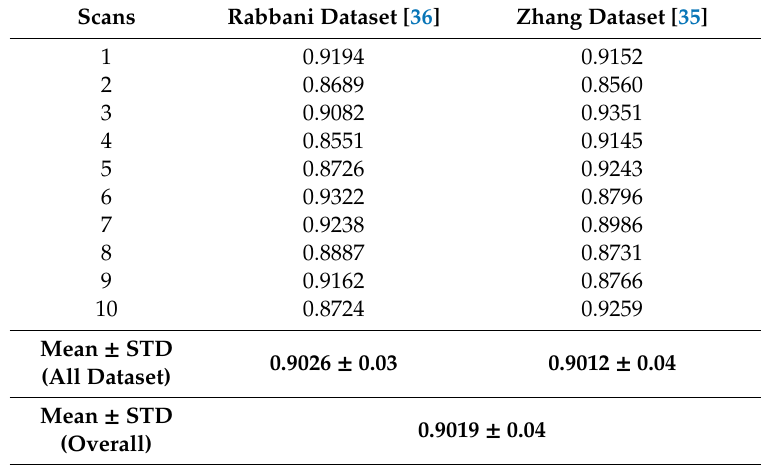
Table 8. Mean dice coe ffi cient for retinal fluids extraction against a local clinician’s